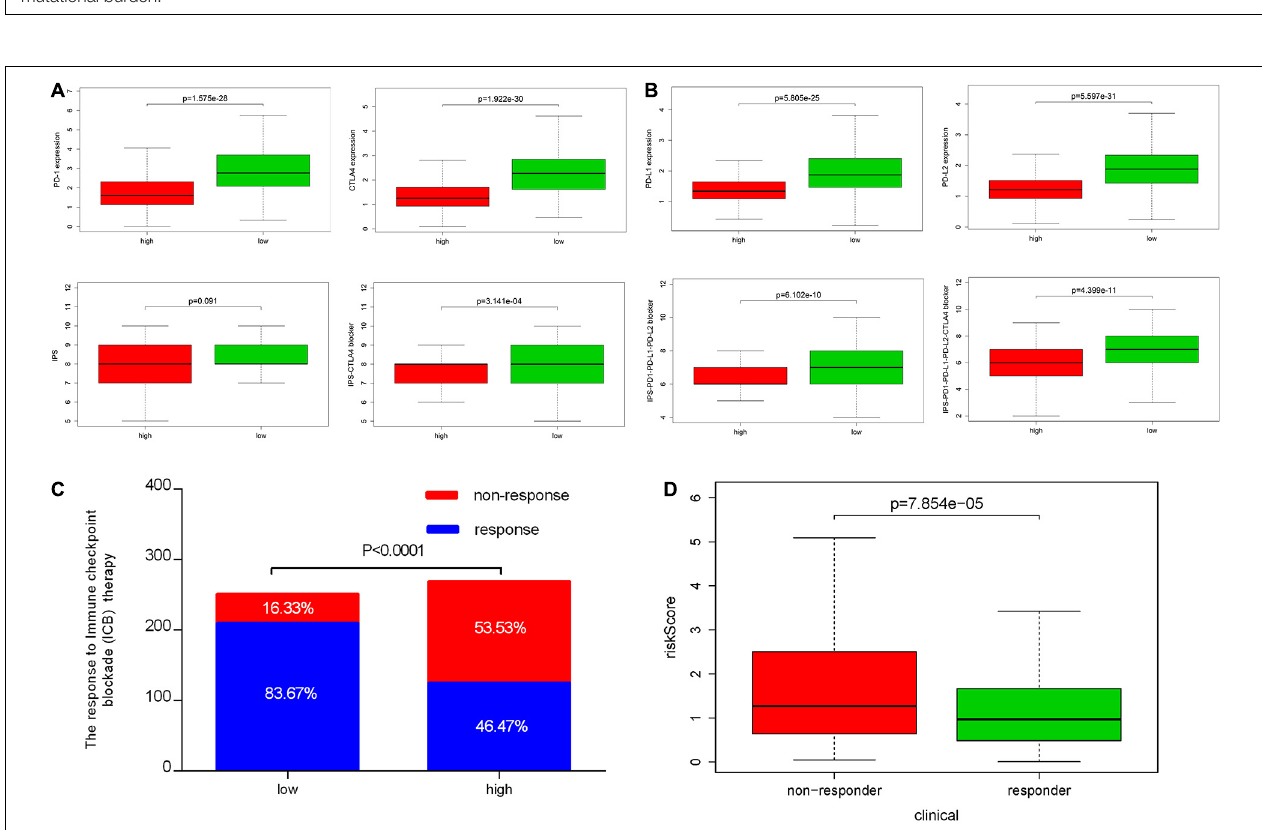
FIGURE 10 | Correlation between IRPS and immune checkpoint molecules and the predicted response to immunotherapy. (A) The gene expression profile of PD1, CTLA-4, PD-L1 and PD-L2 in low-risk and high-risk group. (B) The association between IPS and the IRPS in UCEC patients. (C) The different immunotherapy response rates in low-risk and high-risk group. (D) The relationship between IRPS and immunotherapy response.